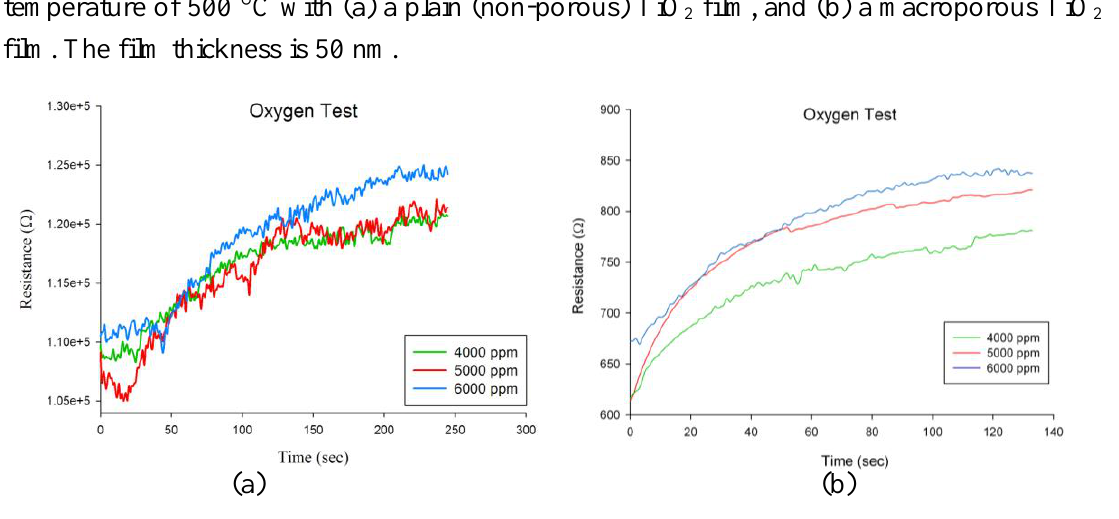
film, and (b) a macroporous TiO 2 2